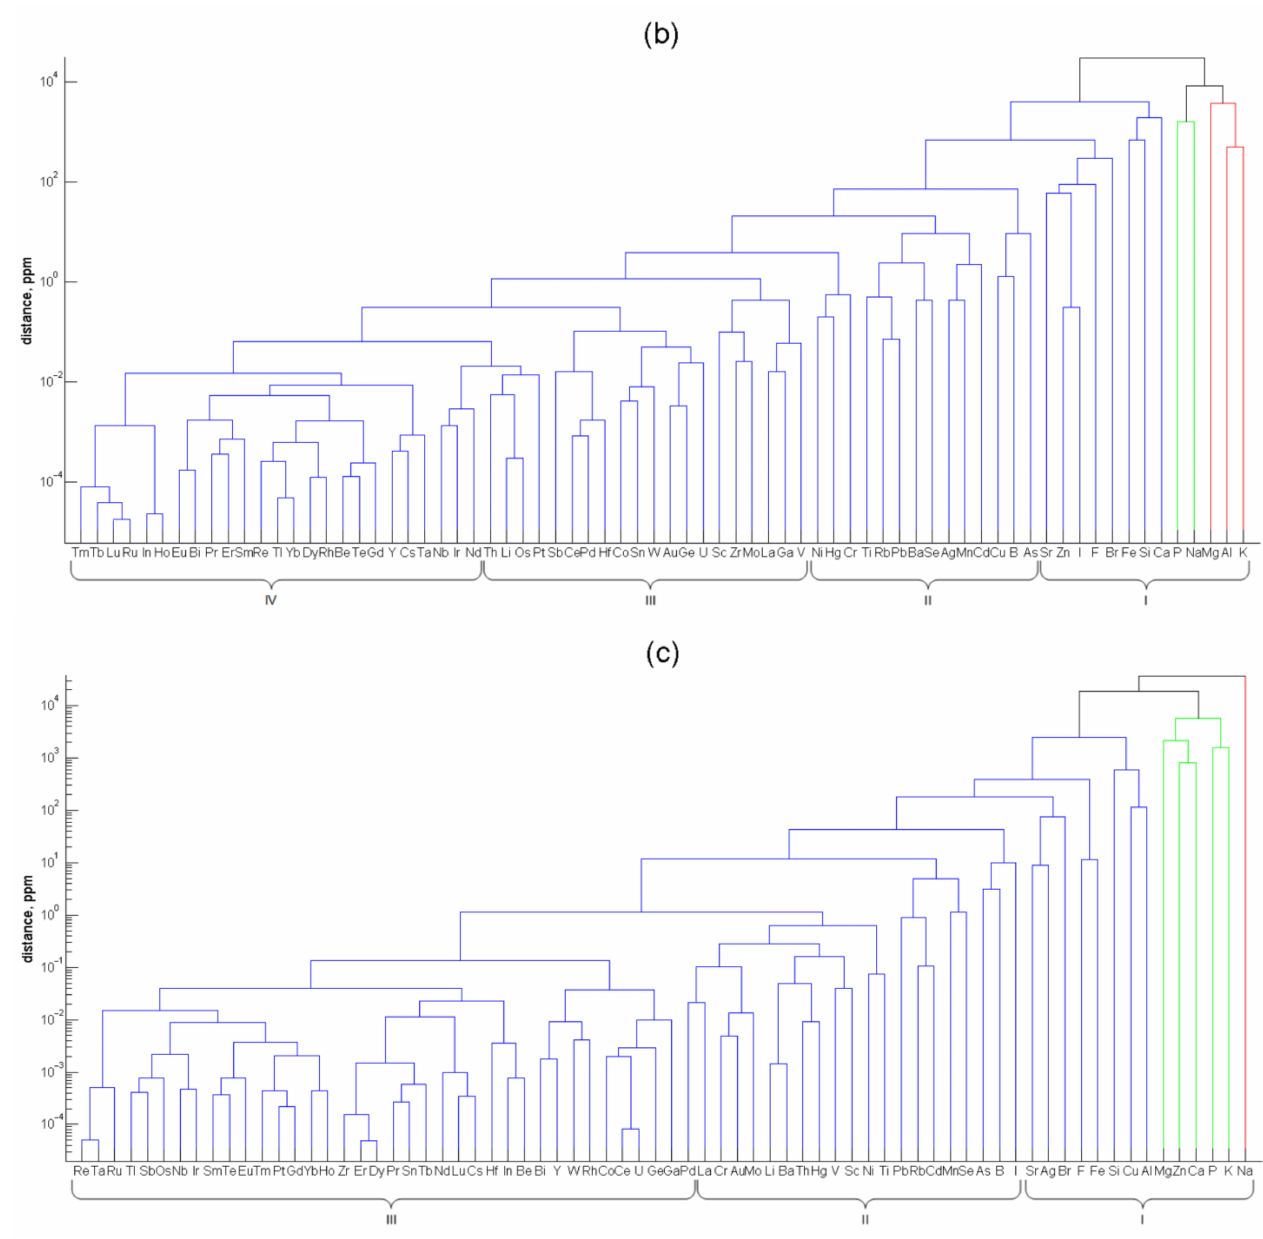
Figure 3. Dendrograms of the non-normalized element contents in soft tissues of ( a ) M. galloprovincialis , ( b ) R. venosa , and ( c ) C. gigas . The partition in the optimal number of clusters denoted by Roman numerals is shown below each